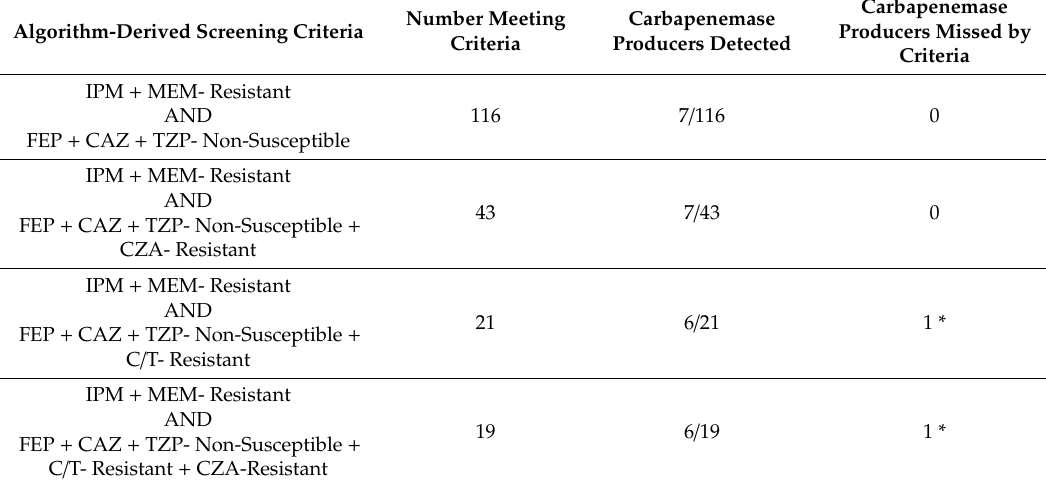
Table 2. Performance of algorithm after application to 1209 clinical P. aeruginosa isolates from a US surveillance study. surveillance study. Algorithm-Derived Screening Algorithm-Derived Screening